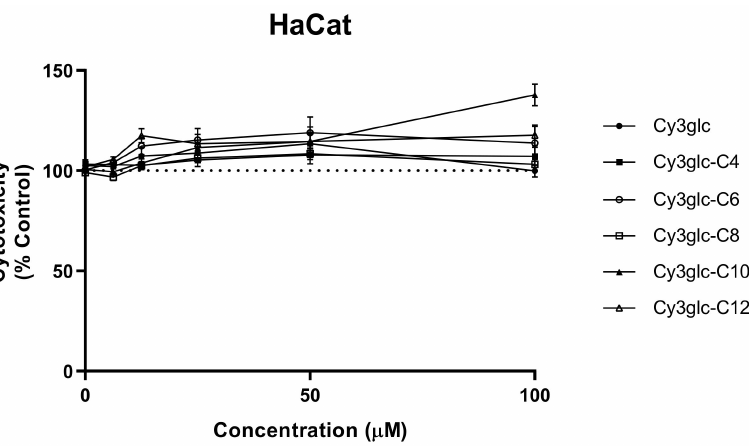
Figure 3. Cytotoxicity activity of Cy3glc and Cy3glc-fatty acid derivatives in spontaneously transformed aneuploid immortal keratinocyte cell line from adult human skin (HaCat) evaluated by MTT